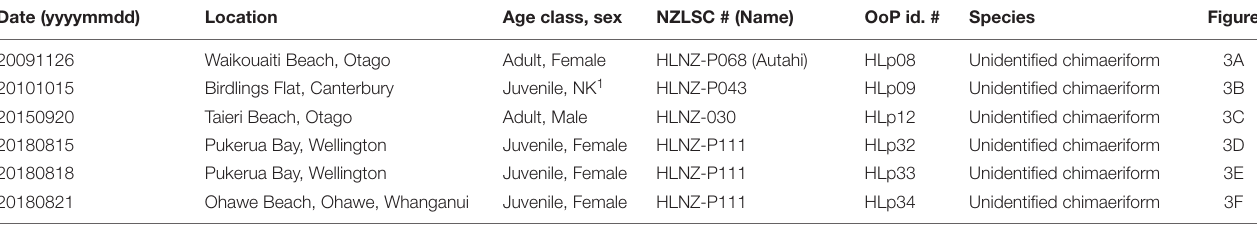
TABLE 5 | Observations of leopard seals ( Hydrurga leptonyx ) predating on chondrichthyans in New Zealand waters, where embedded spines were found. Date (yyyymmdd)